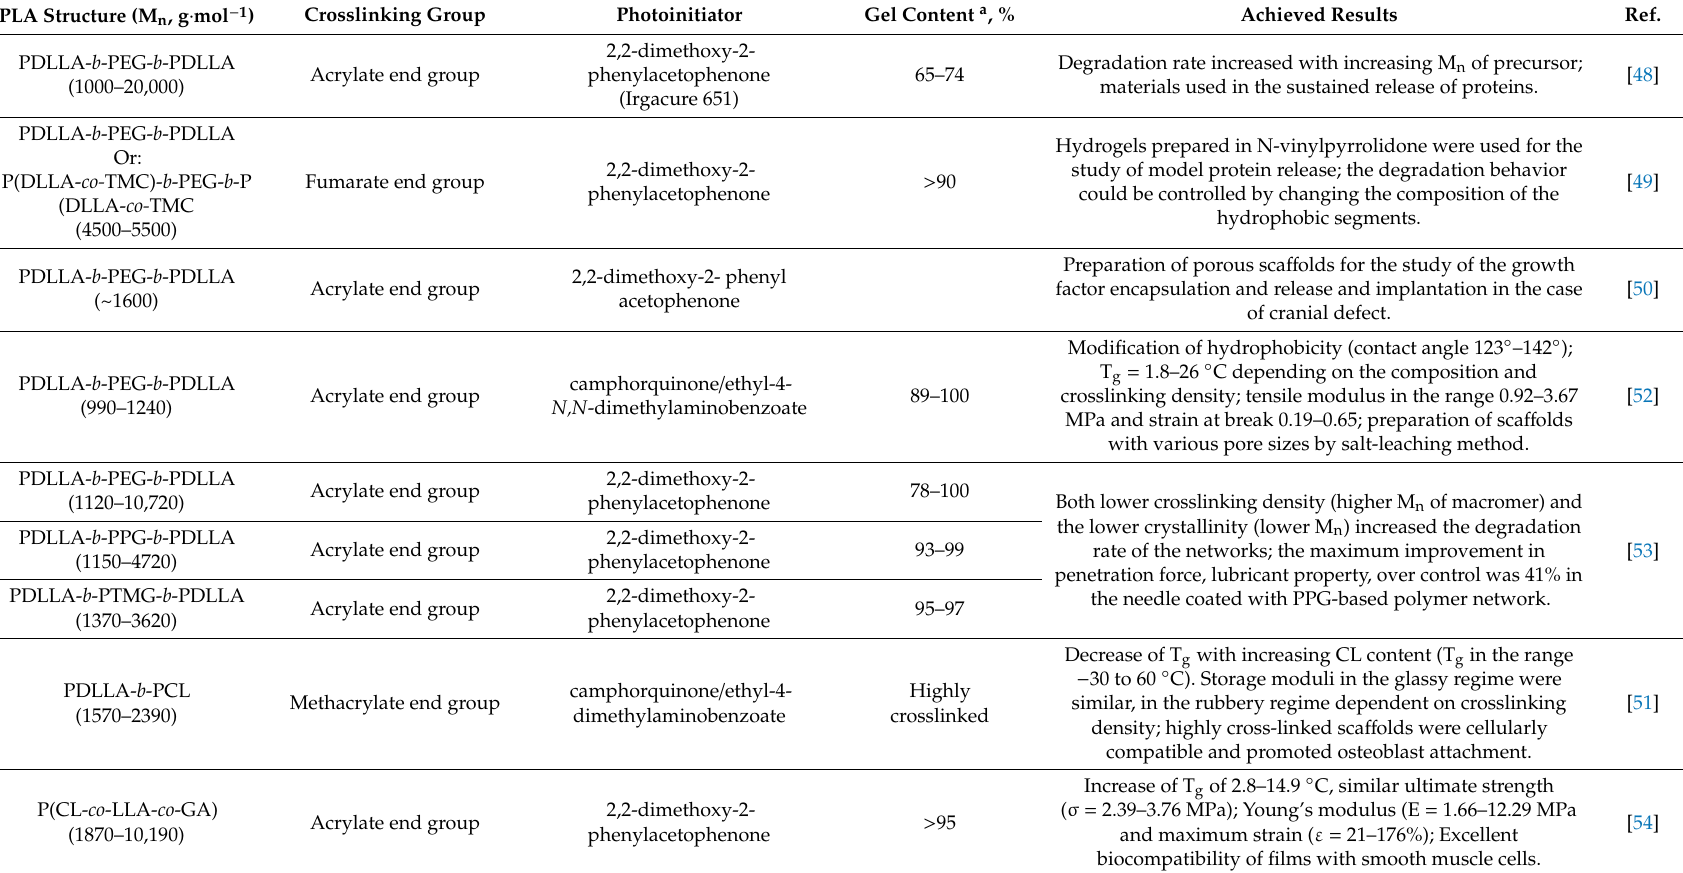
Table 2. Conditions of photo-crosslinking of linear and star PLA low molecular weight (co)polymers and observed results. UV light was used to induce crosslinking (visible or laser light / 2PP, when